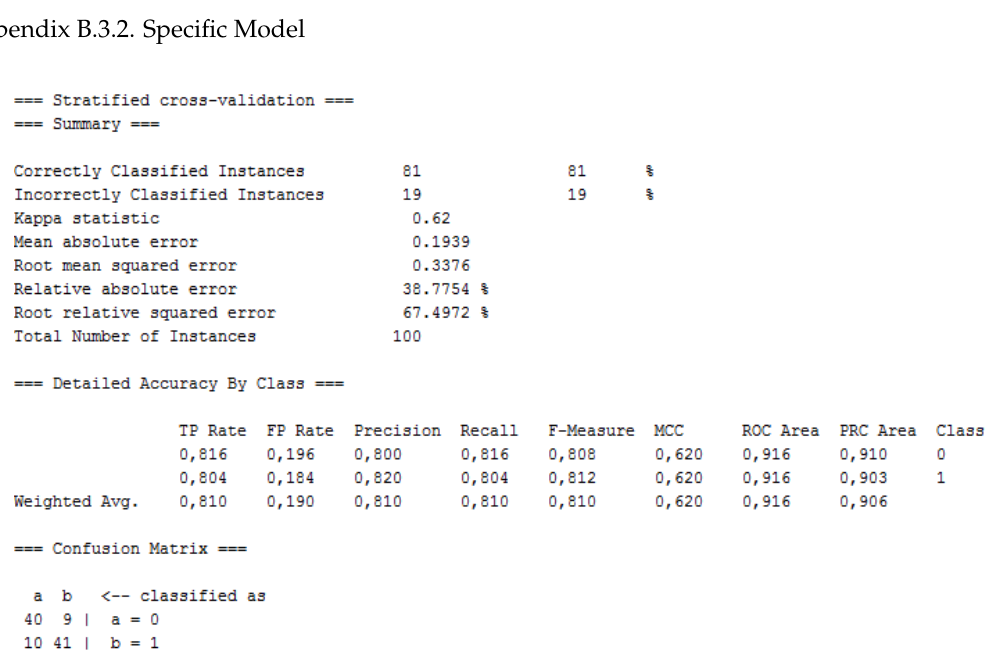
Figure A8. Random Tree Results for the Specific